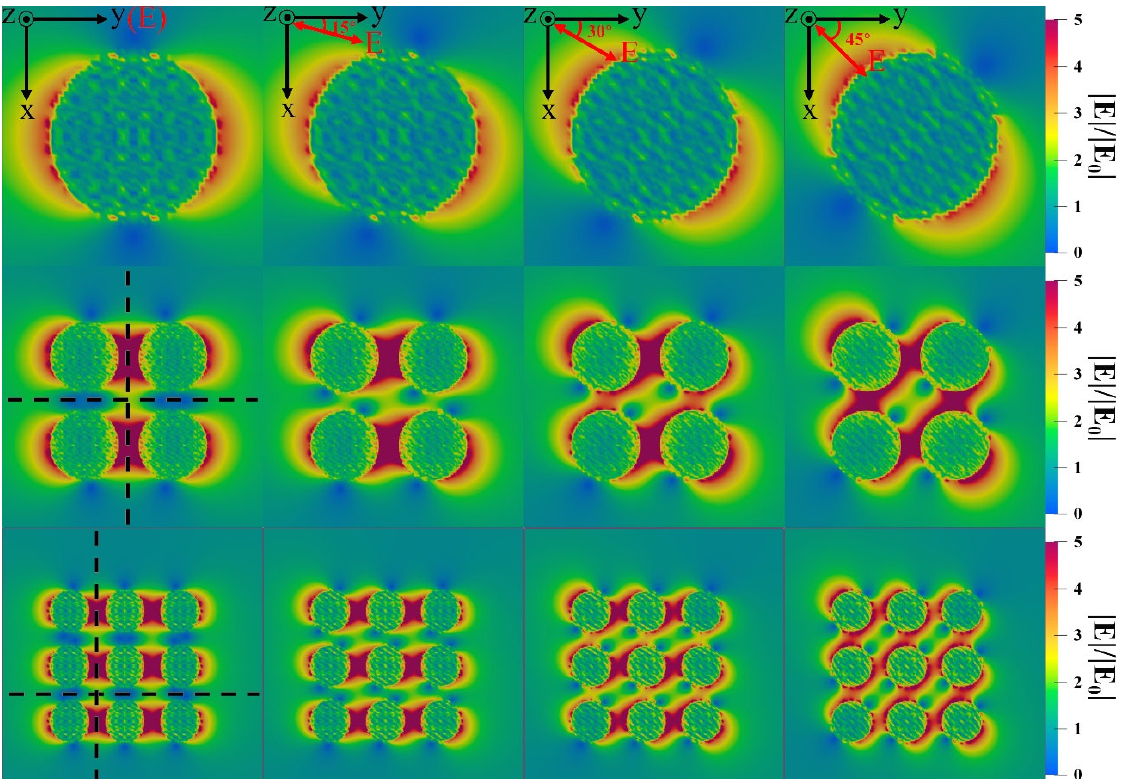
Figure 8. Near-field distribution of single and square arrays at different illumination polarization angles with the incident light wavelength of 532nm: the single ( R = 20 nm ), 2 × 2 array ( R = 20 nm , d = 10 nm ) and 3 × 3 array ( R = 14 nm , d = 10 nm